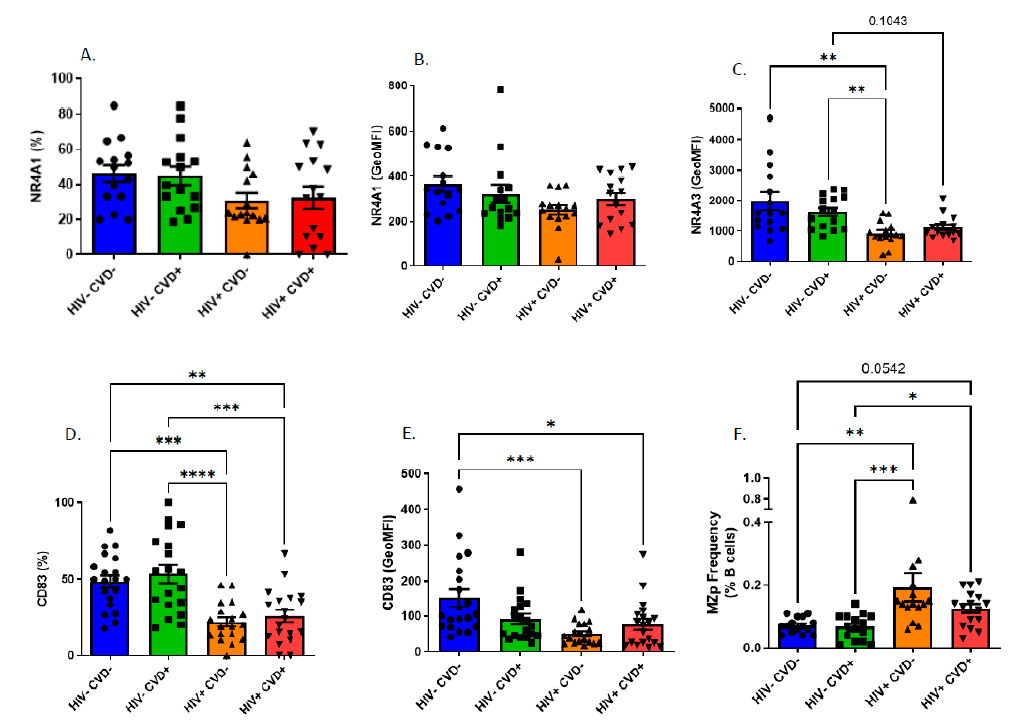
Figure 3. Expression levels of immunoregulatory markers NR4A1, NR4A3 and CD83 by blood mar- ginal zone precursor-like (MZp) B-cells of HIV-uninfected (HIV − ) and HIV-infected (HIV+) individ- uals of the CHACS. Expression levels of NR4A1, NR4A3 and CD83 by blood MZp of HIV-unin- fected participants, without and with cardiovascular disease (CVD) (HIV − CVD − , HIV − CVD+, re- spectively), and HIV-infected participants, without and with CVD (HIV+ CVD − , HIV+ CVD+, re- spectively) selected in sub-cohort ( A ). Shown are relative frequencies of NR4A1 ( A ) and CD83 ( D ), as well as total relative frequencies of MZp in blood ( F ). MZp NR4A1 ( B ), NR4A3 ( C ) and CD83 ( E ) expression levels. Total relative frequencies of MZp in blood were assessed relative to the percent- age of total blood B-cells, and relative frequencies of MZp expressing NR4A1 and CD83 were as- sessed relative to the percentage of total blood MZp B-cells. Expression levels were assessed with Geometric Mean of Fluorescence Intensity (GeoMFI). Normality was assessed with the Shapiro- Wilk test. A Kruskal-Wallis test with a post-hoc Dunn’s test was used to test for statistical differences